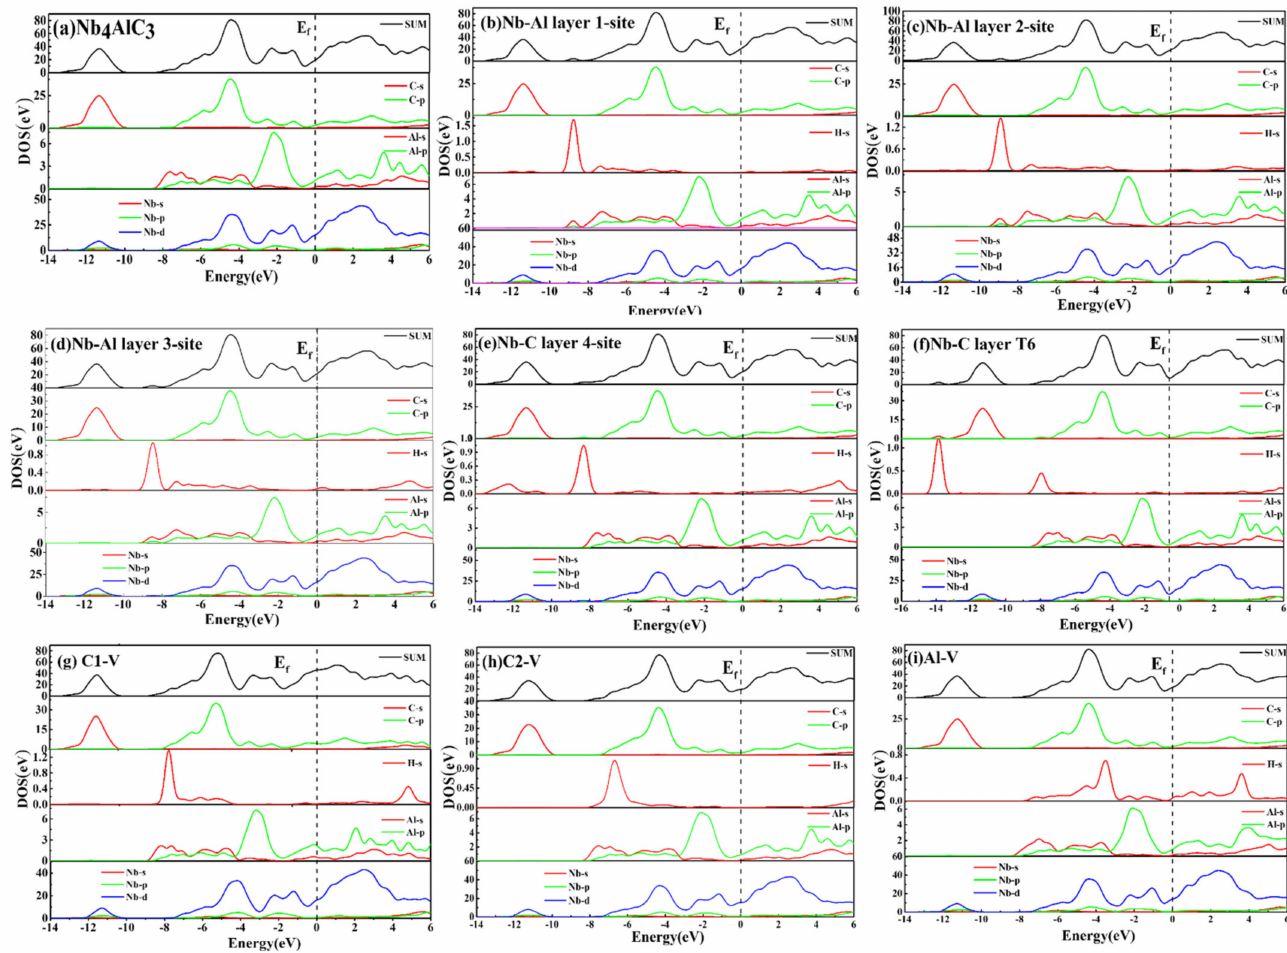
Figure 7. The density of states (DOS) of the H-doped Nb 4 AlC 3